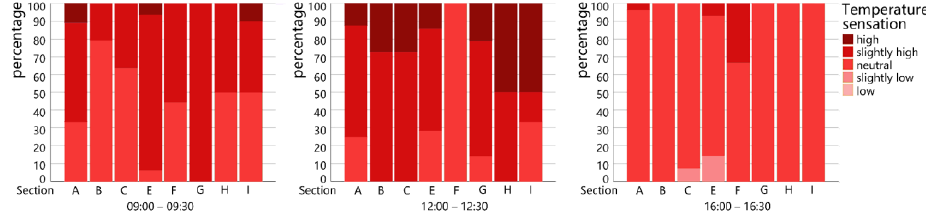
Figure A1. Air temperature sensation votes of the three time periods on 11 September.